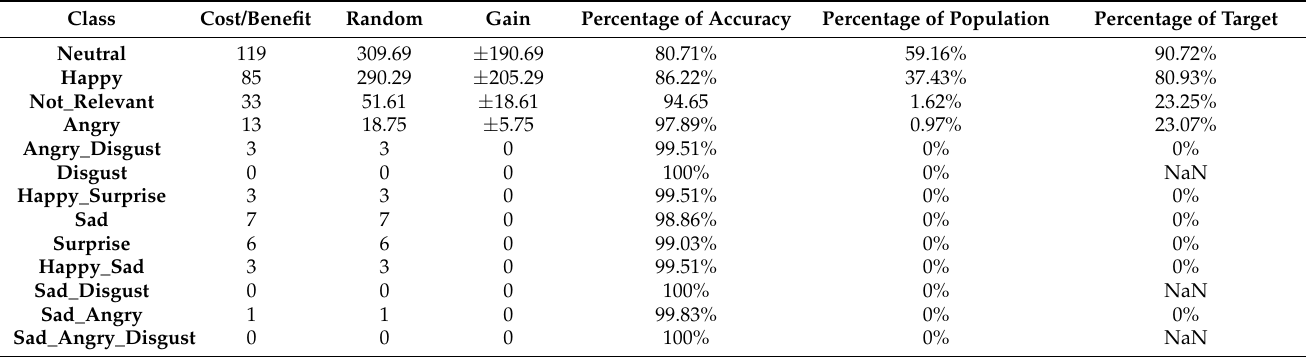
Table 11. Cost/benefit summary (tetrad of feature selection